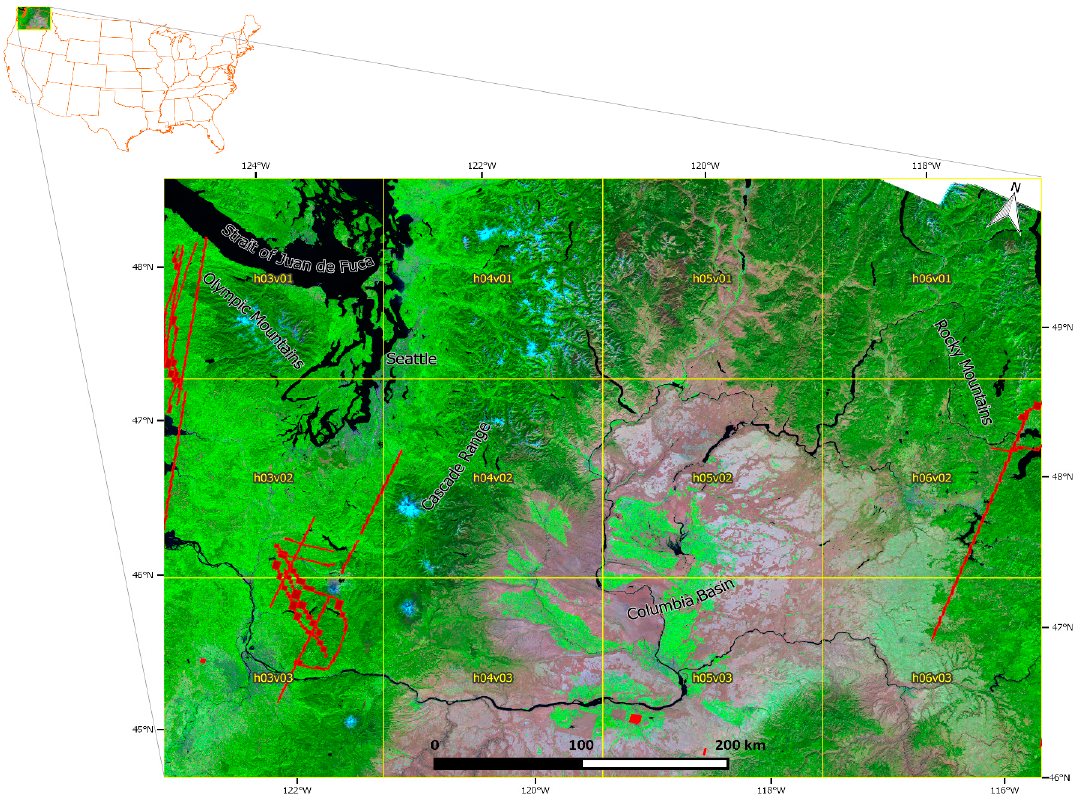
Figure 1. Study area over Washington State, USA, encompassed by 12 Landsat Analysis Ready Data (ARD) tiles (yellow outlines, top left: h03v01, bottom right: h06v03) each composed of 5000 × 5000 30 m pixels. The missing data on the northern border of the northeast tile (shown as white) are from Landsat images acquired only over Canada and so are not processed as ARD. To provide geographic context, the background shows the 5-year median of the Landsat 5 Thematic Mapper (TM) and Landsat 7 Enhanced Thematic Mapper Plus (ETM+) band 5 (red), 4 (green), 3 (blue) atmospherically corrected ARD metrics. The red colors show the Goddard LiDAR, Hyperspectral & Thermal Imager (G-LiHT) acquisition flight